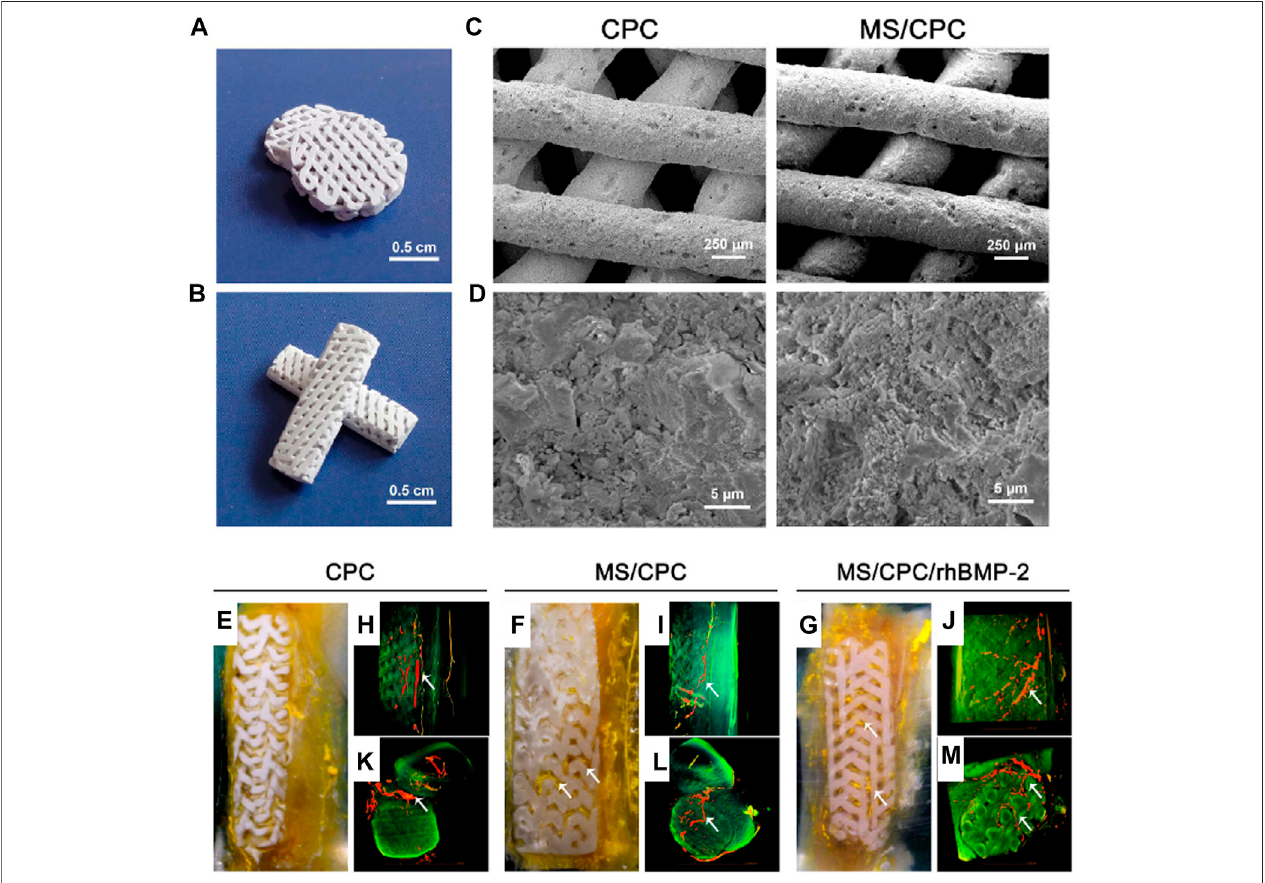
FIGURE 12 | Microstructure and morphology of the MS/CPC scaffolds. (A,B) Digital camera photographs of MS/CPC scaffolds for in vitro (A) and in vivo (B) experiments. Scanningelectron micrographsofCPC and MS/CPC (C) × 150, (D) × 10 K;EffectofMS andrhBMP-2releaseon vascularization.The (E – G) digital camera photographs of PMMA-embedded blocks from longitudinal sections and 3D reconstructed μ CT images of blood vessels from (H – J) the side view and (K – M) the top view of CPC, MS/CPC, and MS/CPC/rhBMP-2 scaffolds after 4 weeks of implantation. White arrow: newly formed blood vessels.